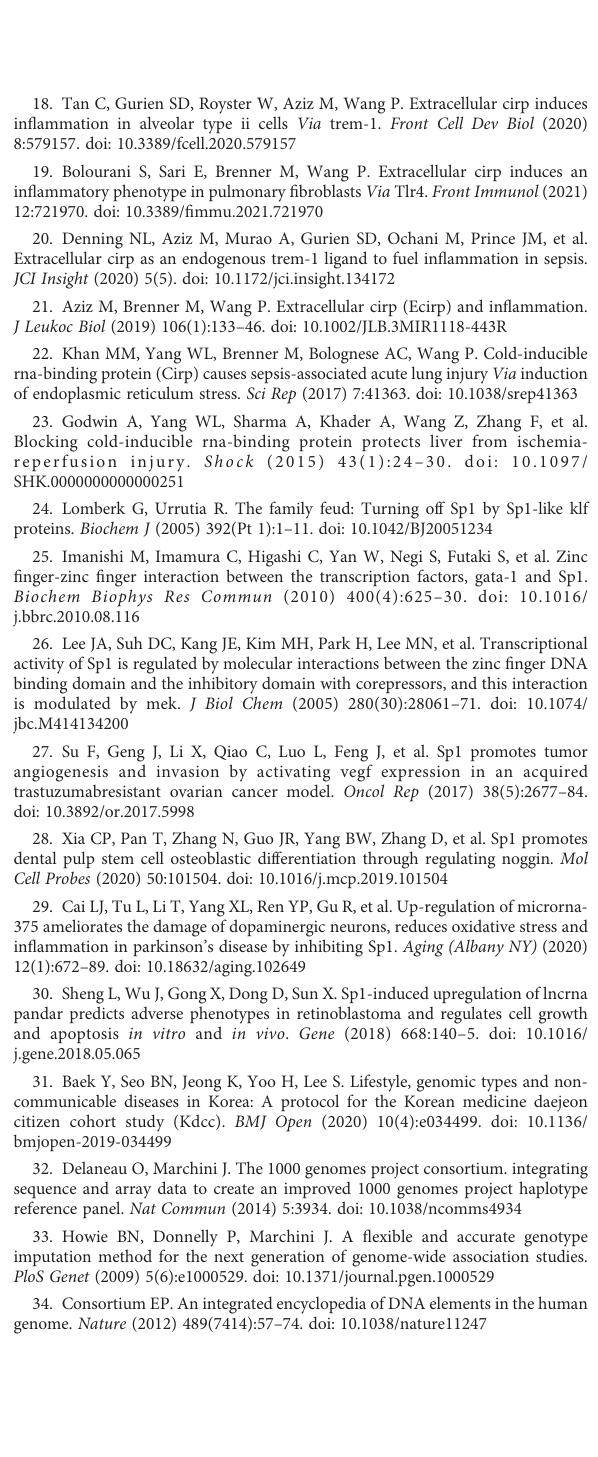
SUPPLEMENTARY FIGURE 2 QQ plot of p-values based on GWAS for the cold sensitivity. The results did not show any in fl ation of the test statistics (lambda = 1.024) SUPPLEMENTARY FIGURE 3 Functional effects of SNPs rs11170509, rs11170516, rs35437931, rs7962345, rs12828860, rs11170510, and rs58123204. HEK293 cells